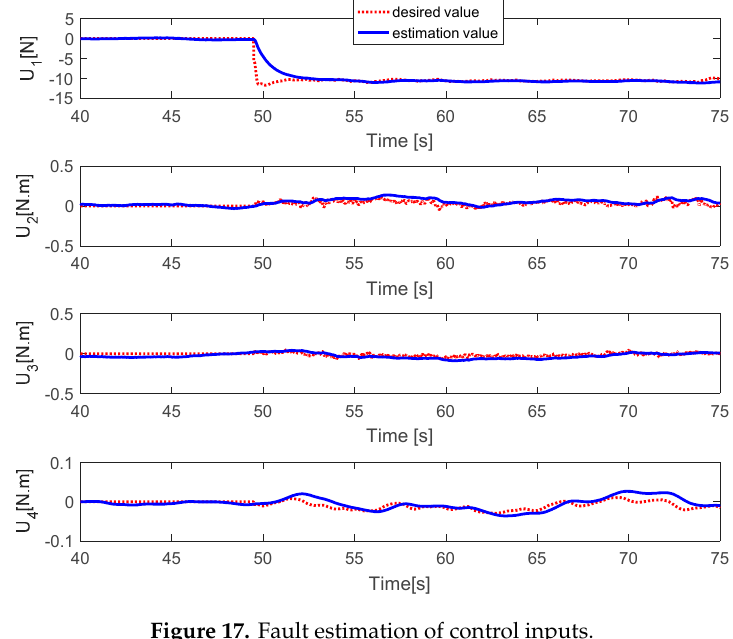
Figure 17. Fault estimation of control inputs.